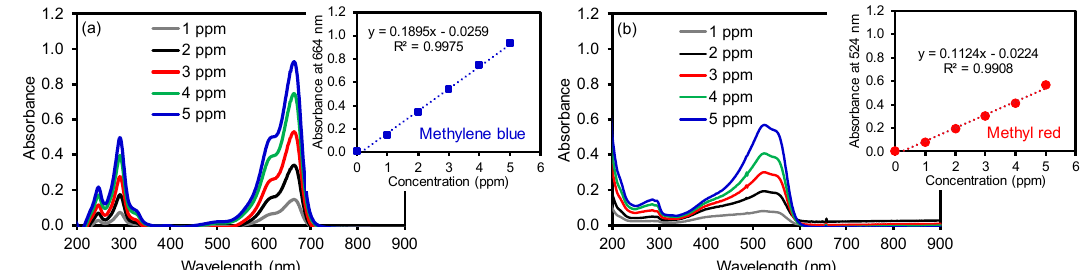
Figure4. Absorptionpatternsof( a )MBand( b )MRasafunctionofconcentrationandtheircorresponding Figure 4. Absorption patterns of ( a ) MB and ( b ) MR as a function of concentration and their Polymers 2020 , 12 , x FOR PEER REVIEW 8 of 14 calibration curves. corresponding calibration curves.